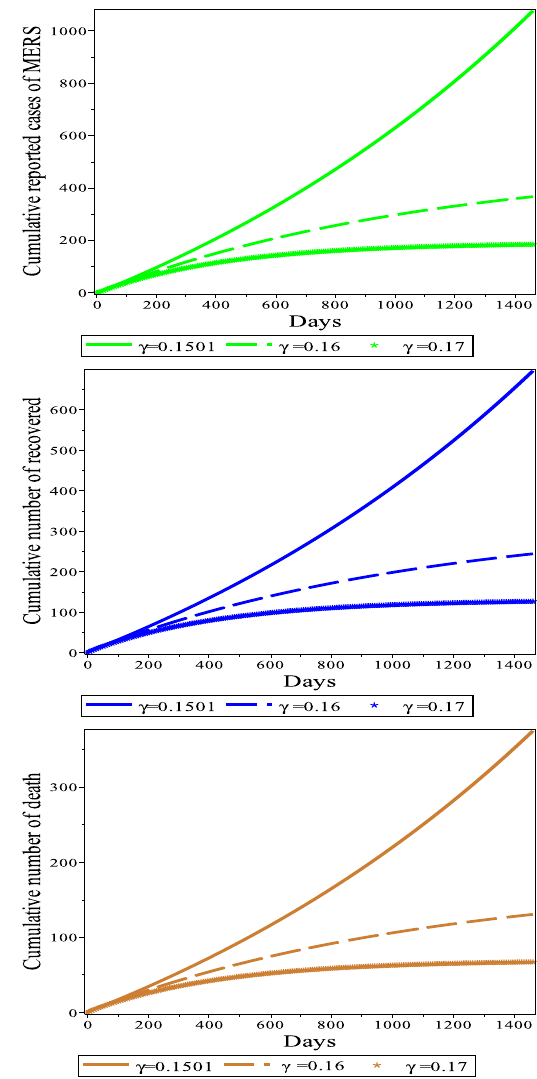
Fig. 4: Model simulations with three values γ = 0 . 1501 , 0 . 16 , 0 . 17 showing the cumulative reported cases of MERS (T), cumulative number of recovered (M), and cumulative number of death (B). The rest of the parameter values are given